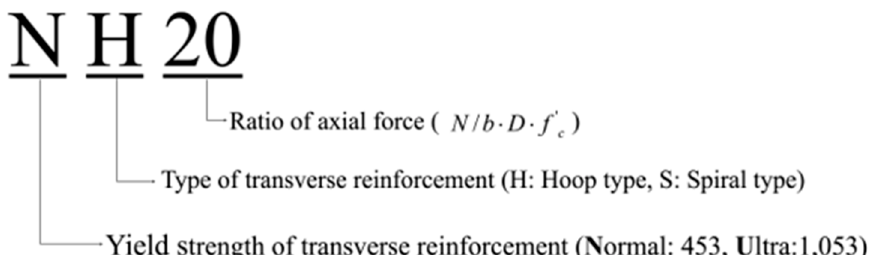
Figure 2. Name of